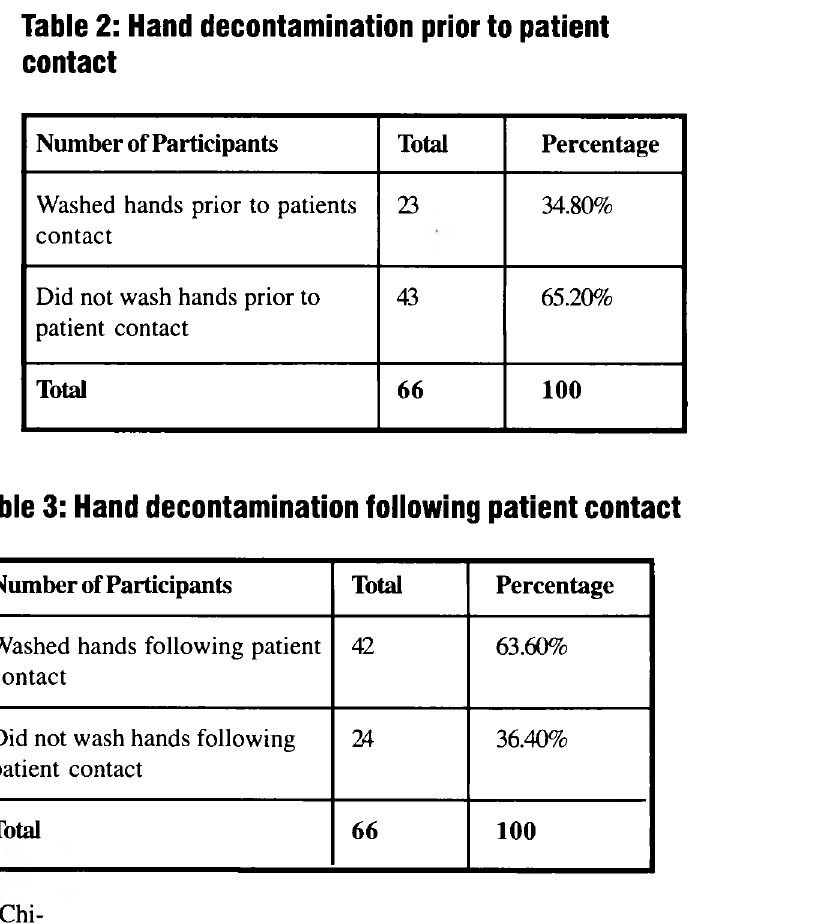
Table 2: Hand decontamination prior to patient